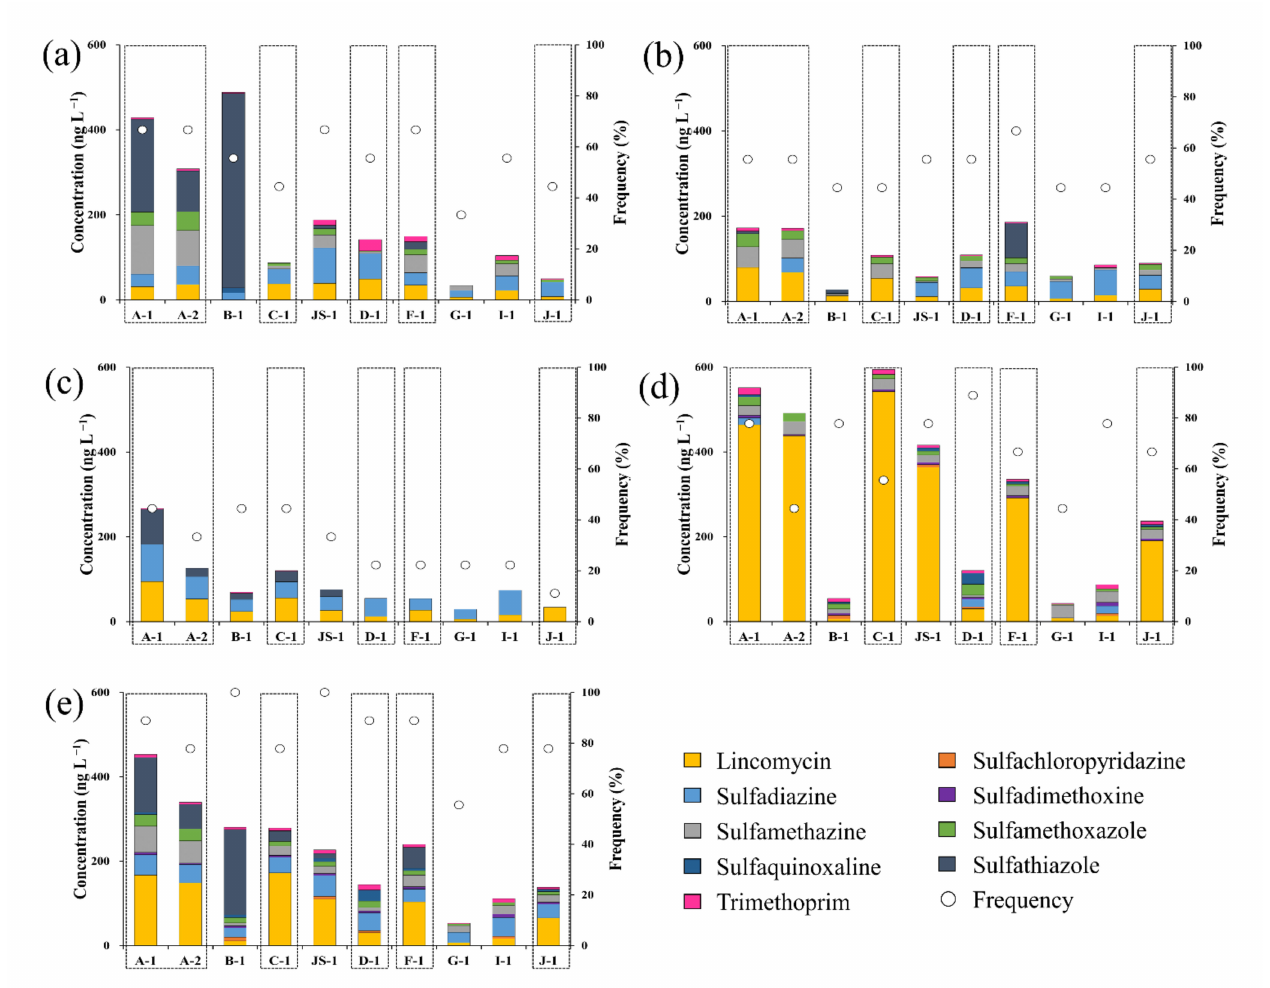
Figure 5. Residual cumulative concentrations of antibiotics at each sampling point during various months: ( a ) March, ( b ) June, ( c ) August, ( d ) December, ( e ) Average concentrations of samples from March to December; Yellow: lincomycin, Orange: SCP, Sky blue: SUL, Violet: SDX, Grey: SMZ, Green: SMX, Dark blue: SQX, Black: STZ, Pink: TMP, circle: frequency, and box: main